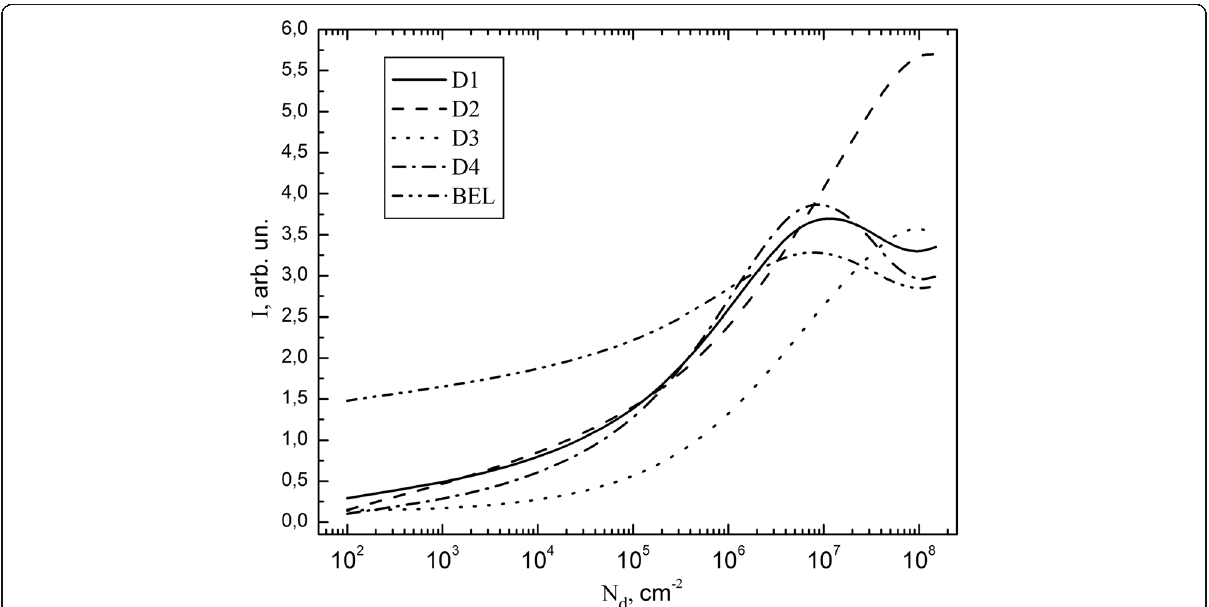
Fig. 2 Dependence of EL peaks value (D1 – D4 and BEL) of samples subjected to plastic deformation on the dislocations concentration on the surface (111) of p-type